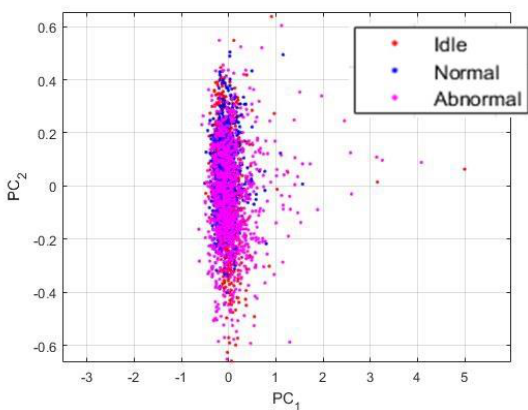
Figure 19. Projections of the data represented by their statistical features.